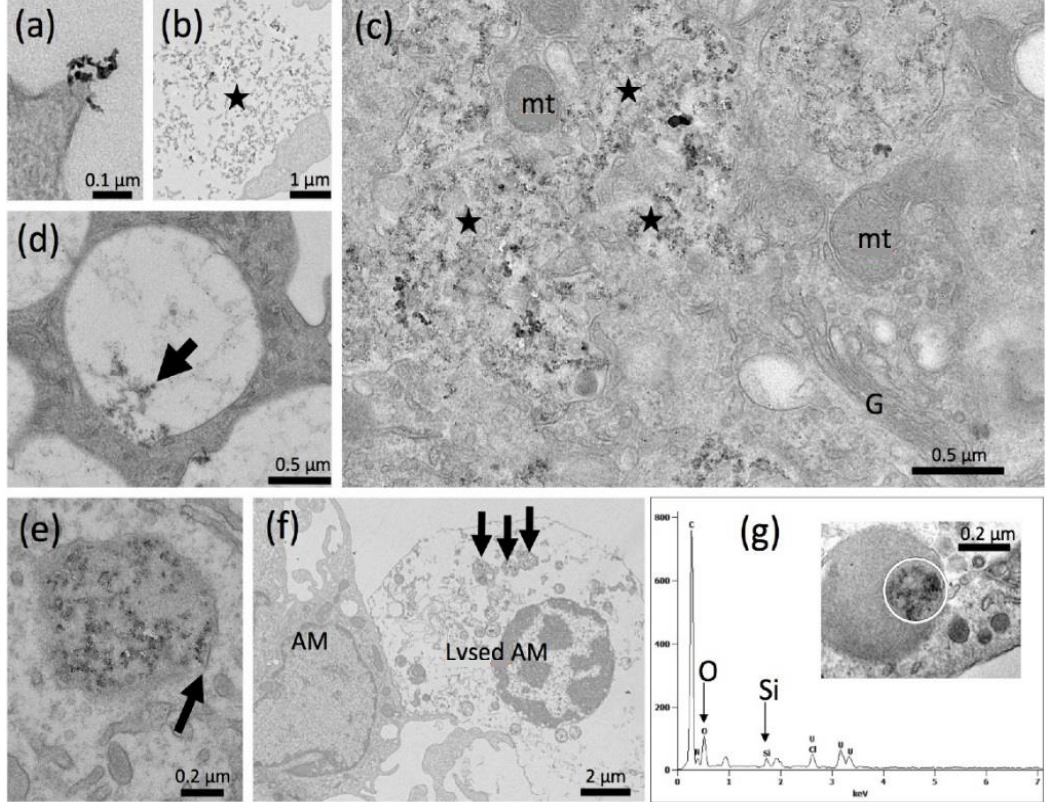
Figure 7. Detection of fumed silica nanoparticles (F-3) in NR8383 cells by transmission electron microscopy (TEM). Cells were treated with 11.25 µ g F-3 per mL in serum-free F-12K and fixed after 90 min ( a – d ) and after 16 h ( e , f ). ( a ) F-3 aggregate/agglomerate attached to a cell. ( b ) Assembly of F-3 particles (asterisk) outside a cell. ( c ) Numerous F-3 particles gathered in endosomal structures of the cytoplasm (asterisks); in the upper right corner electron dense material is enclosed in an autophagosome-like vesicle close to the Golgi apparatus (G) and several mitochondria (mt). ( d ) F-3 particle in a large clear vacuole, and ( e ) within a lysosome. ( f ) A lysed alveolar macrophage (AM) with F-3-laden phagolysosomes (arrows). ( g ) Energy dispersive x-ray analysis (TEM-EDX) of a F-3-laden lysosome (inset), white circle marks analyzed area. Signals (in arbitrary units) were obtained for silicon (Si) and oxygen (O) at typical positions of the spectrum (in keV), confirming that the electron dense material is SiO 2